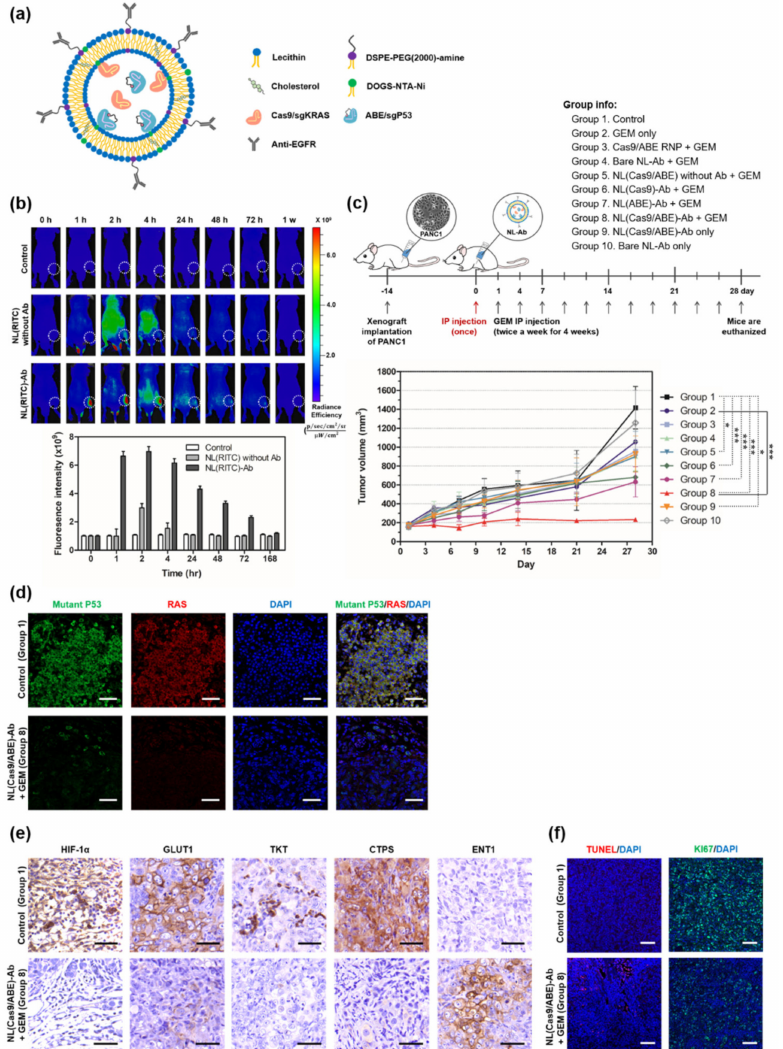
Figure 5. Dual-gene editing nanoliposome system as an overcoming drug-resistance for PDAC. ( a ) Graphical summary of NL(Cas9/ABE)-Ab composition. ( b ) Dynamic distributions of tumor targeting efficiency by NL with or without Ab in vivo. Mice were injected intraperitoneally once with NL-Ab labeled with RITC. PANC1 xenograft tumor was marked as white circles. ( c ) The scheme of PANC1 xenografts co-administrated with NL(Cas9/ABE)-Ab and gemcitabine.